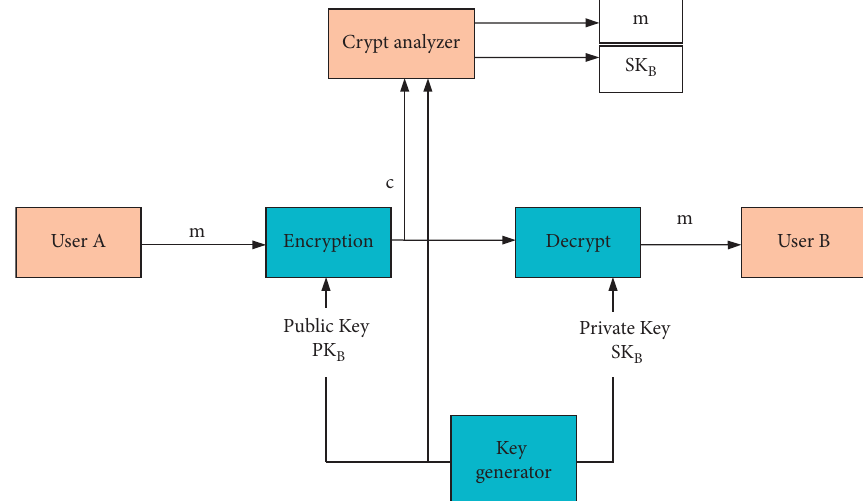
Figure 1: Communication model of PKE